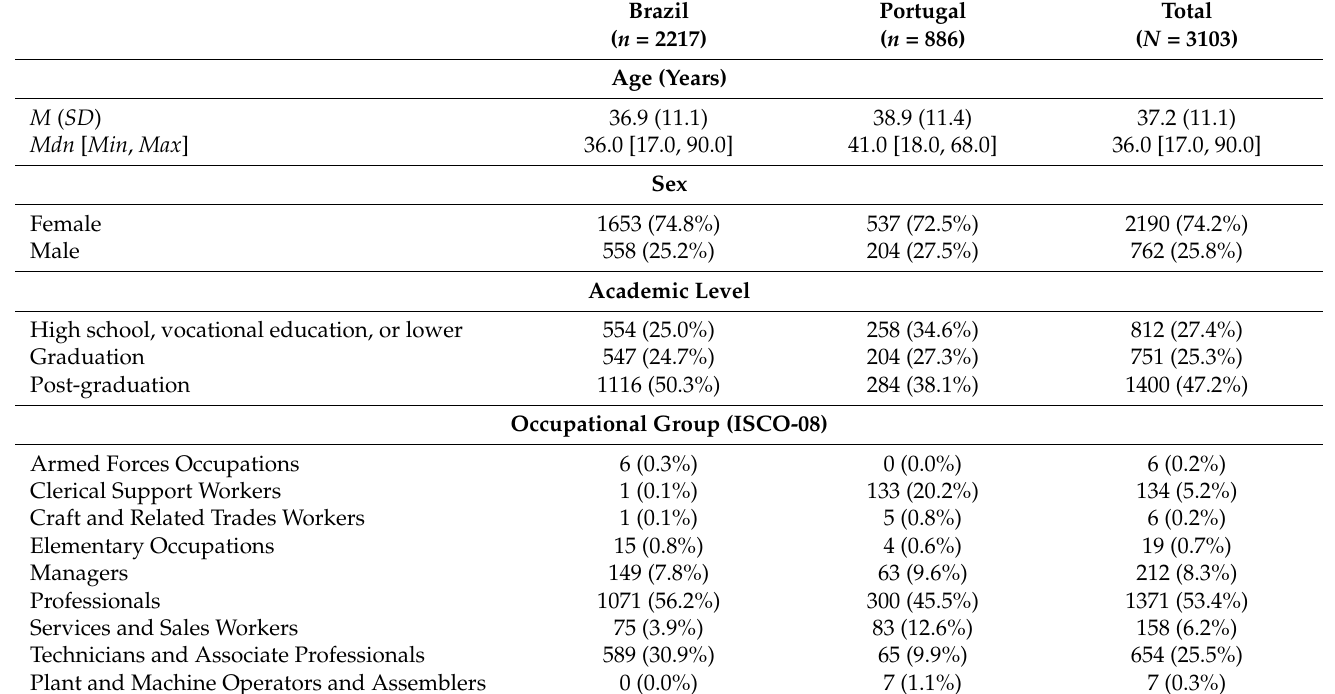
Table 2. Descriptive statistics of the samples’ sociodemographic, and occupational group